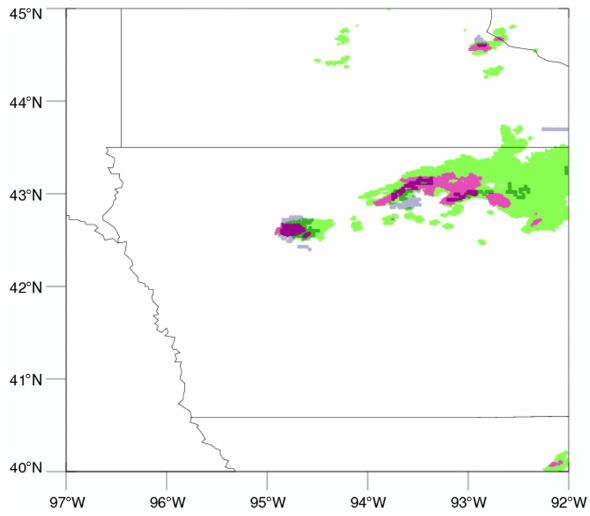
Figure 6. Convective regions detected by GOES-16 (white regions in Fig. 5d) are colored in navy on top of MRMS PrecipFlag at 19:30UTC on 28 June 2017. (Same figure as Fig. 3d. Pink rep- resents convective while green represents